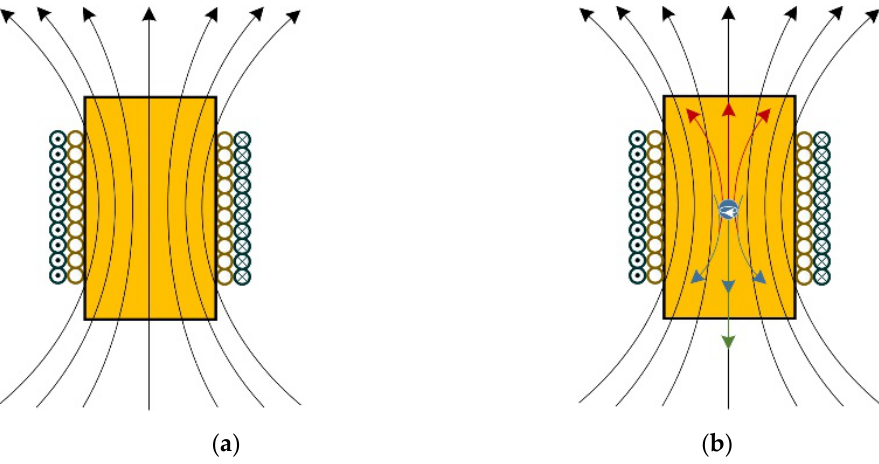
Figure 2. The magnetic field distribution of the sensor-designed sensor: ( a ) no metal debris flows through; ( b ) when ferrous metal debris enters the sensor.